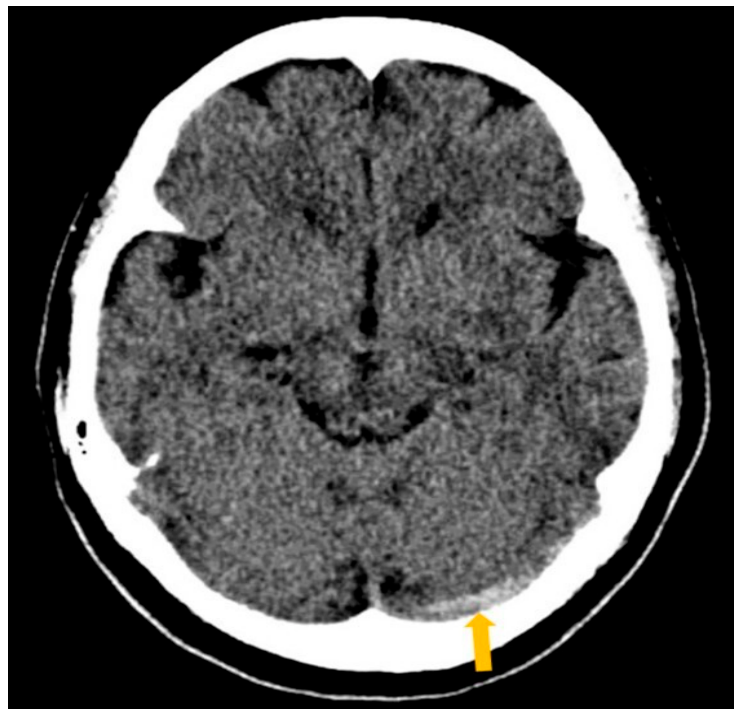
Figure 1. Non-contrast brain computed tomography (CT) at first emergency room visit revealed an asymmetric hyperdensity of the left transverse sinus (dense vein sign), consistent with acute throm- bosis with no associated parenchymal edema or